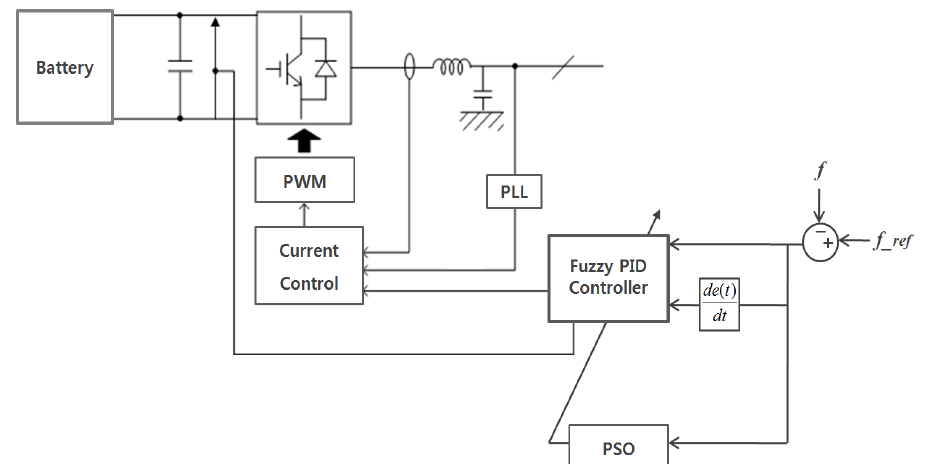
Figure 12. Configuration for the tuning of fuzzy PID controller using PSO.